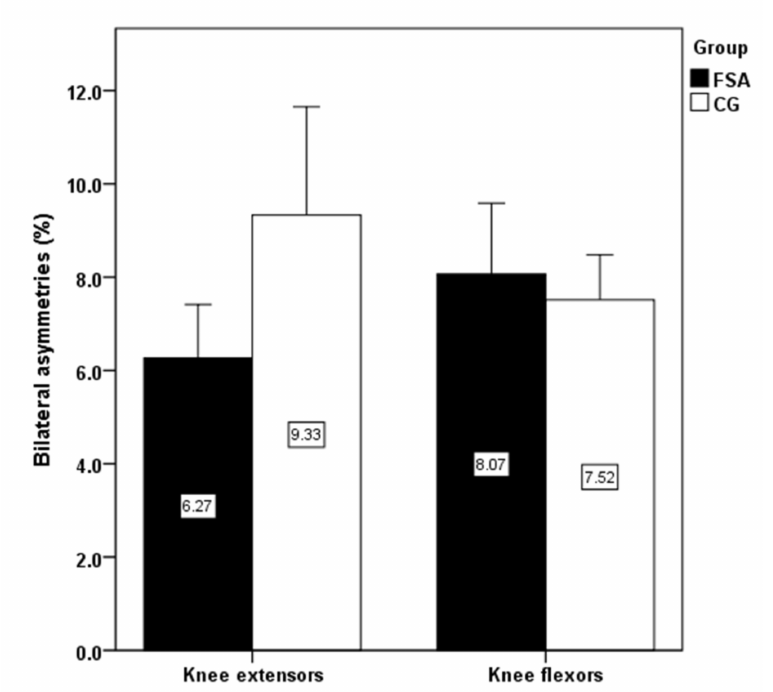
Figure 3. Comparison of bilateral strength differences between groups. Note: FSA: fire sports athletes; CG: control